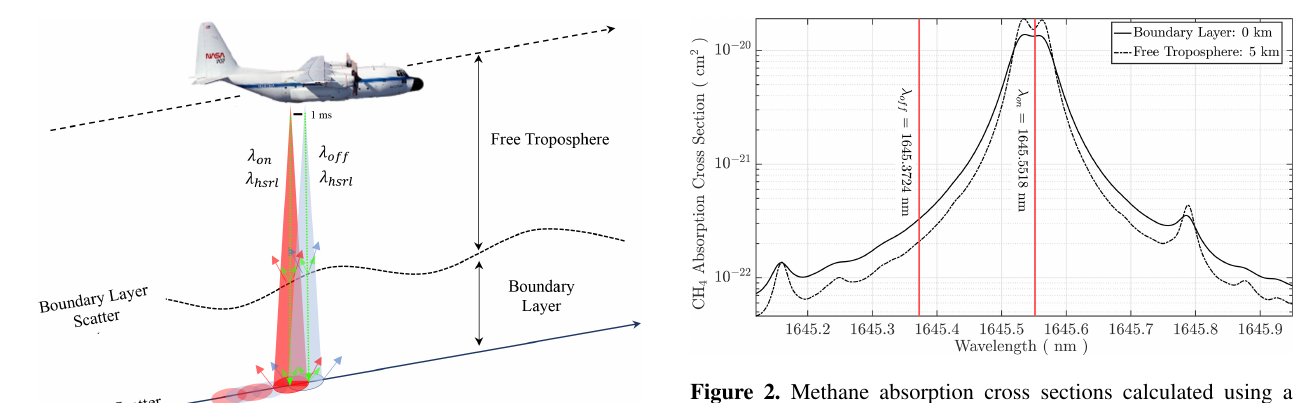
Figure 2. Methane absorption cross sections calculated using a Voigt line shape for a standard atmosphere at 0 and 5km altitude. The online, 1645.5518nm, and offline, 1645.3724nm, wavelengths are shown in